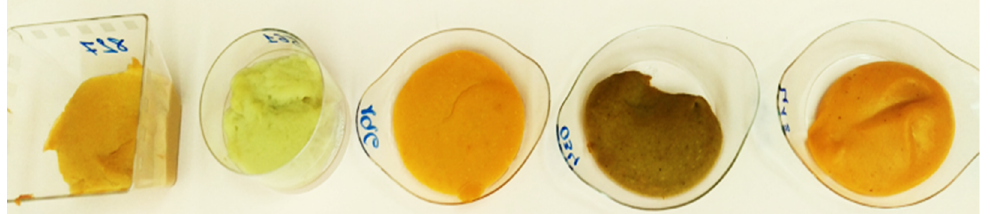
Figure A1. Samples of the texture-modified dishes for CP dysphagia offered to the judges for the CATA method. From left to right: chickpea stew (CS), halibut with green sauce (H), pasta bolognese (PB), lentils with rice (LR), and chicken stew (ChS).